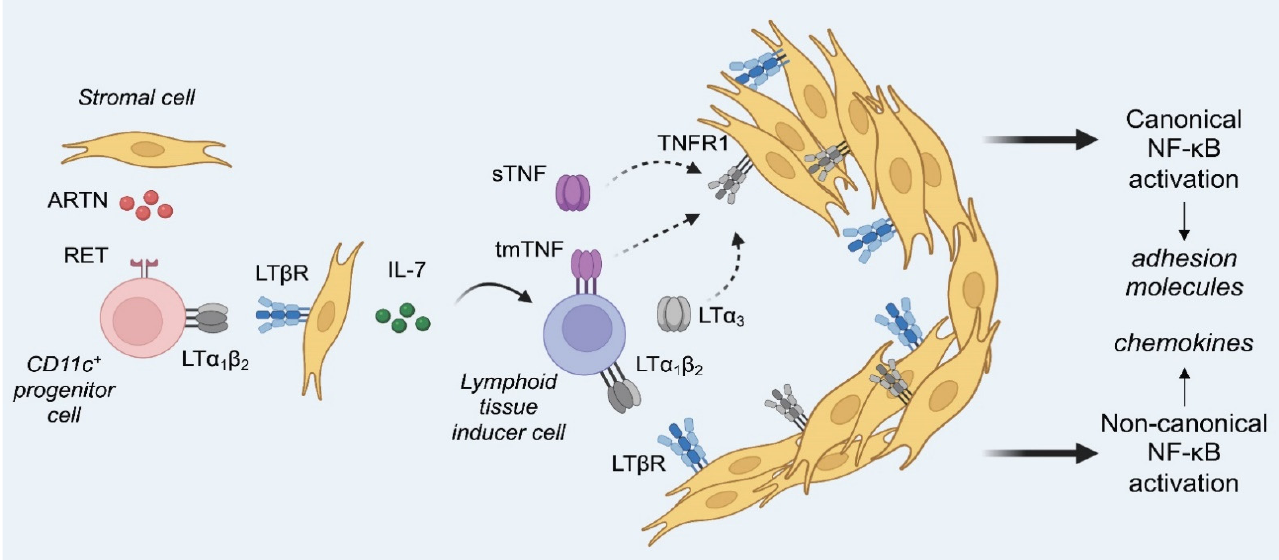
Figure 4. A model of a stepwise contribution of LT α and TNF in Peyer’s patch development. Stromal cells produce ARTN which binds to RET receptor on a CD11c + hematopoietic progenitor cell. RET activation may lead to the induction of LT α 1 β 2 on CD11c + cells. CD11c + cells then interact with LT β R + stromal cells which produce IL-7 for the survival of LTi cells. LTi cells start to express LT α 1 β 2 , which interacts with LT β R on stromal cells leading to the activation of the non-canonical NF- κ B pathway. LTi cells may also express tmTNF, sTNF, and LT α 3 that bind to TNFR1 on a yet unknown cell type, presumably on stromal cells, leading to the activation of canonical NF- κ B pathway. Both non- canonical and canonical NF- κ B pathways synergize to produce chemokines and adhesion molecules that attract and retain lymphocytes in PP. Created with